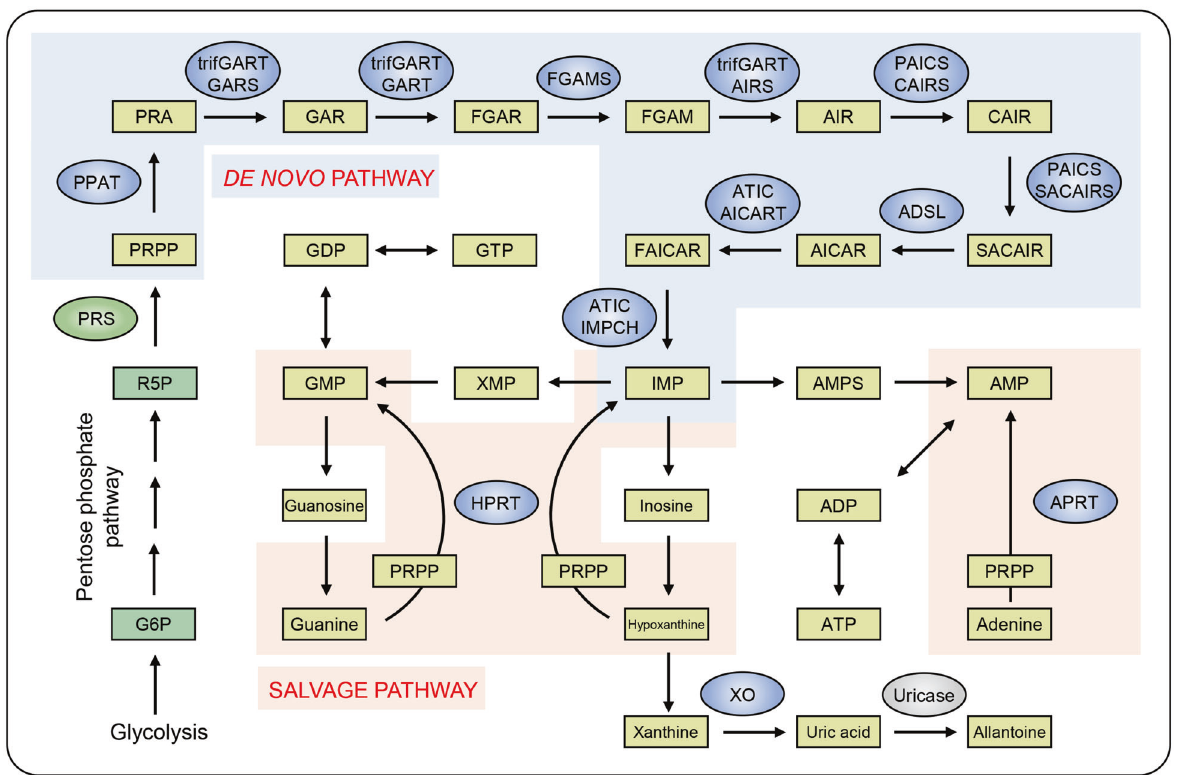
Fig. 2 De novo and salvage pathway for purine synthesis. PRPP generated from glycolysis and pentose phosphate pathway (green) serves as substrate for de novo purine synthesis (blue background). After 10-step reaction catalysed by six enzymes with different functional domains, IMP is produced as the end of de novo pathway. Salvage pathway (orange background) is mainly catalysed by two enzymes, namely HPRT and APRT. In this pathway, PRPP is also needed, and several nucleosides serve as co-substrates for the production of nucleotides. The fi nal metabolite uric acid is further oxidised by uricase (grey), which is expressed in most organisms but lost in humans and a part of